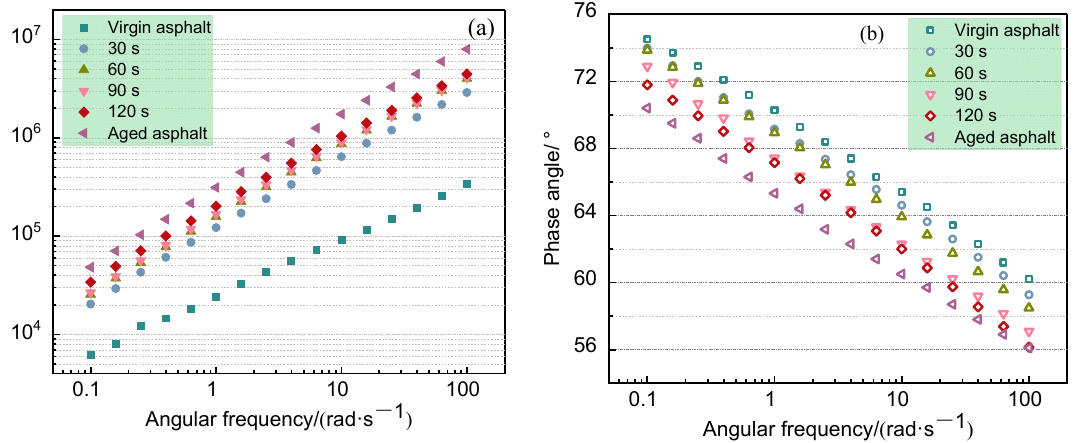
Figure 8. Rheological properties: ( a ) complex modulus master curves at 25 °C for blended asphalt with different mixing durations; ( b ) phase angle master curves at 25 °C for blended asphalt with different mixing durations.